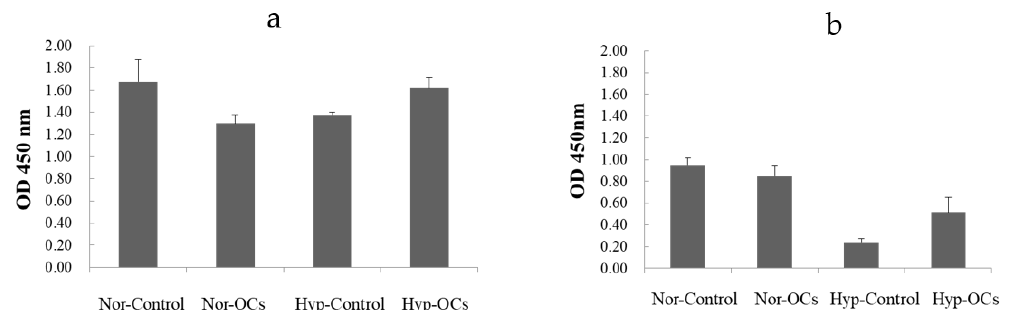
Figure 5. Human umbilical vein endothelial cell (HUVEC) proliferation assay was performed using cell counting kit-8 (CCK-8) for hypoxia condition (n = 3); after 3 days ( a ) and after 7 days ( b ). Nor: normoxia condition (5% O 2 ), Hyp: hypoxia condition (1% O 2 )